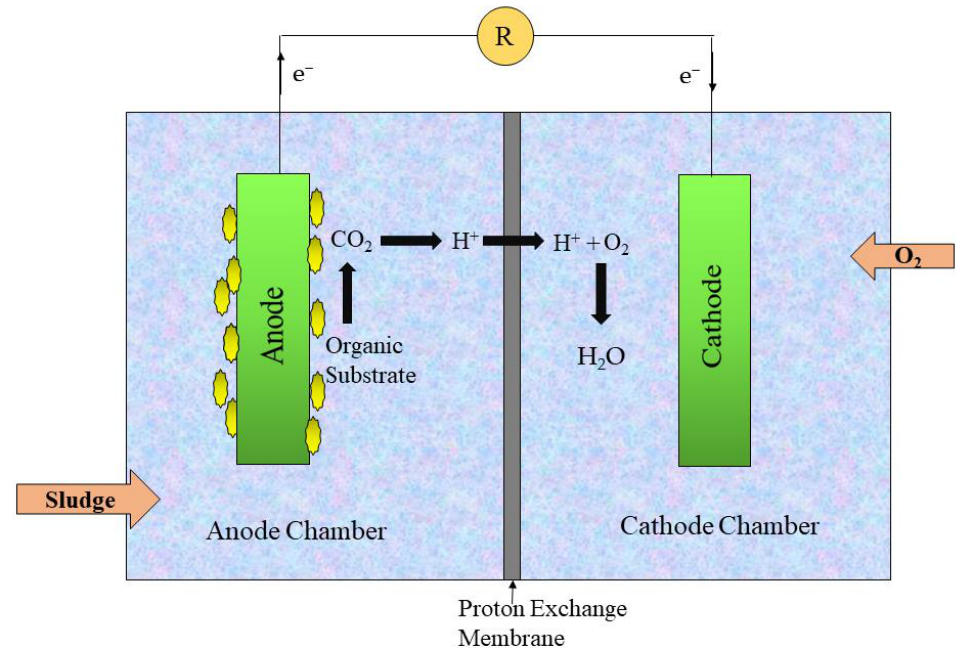
Figure 7. Illustration of algae-assisted cathode in MFC.